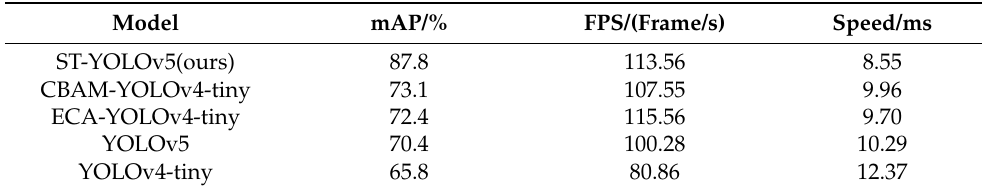
Table 2. Training and testing results of the improved model.